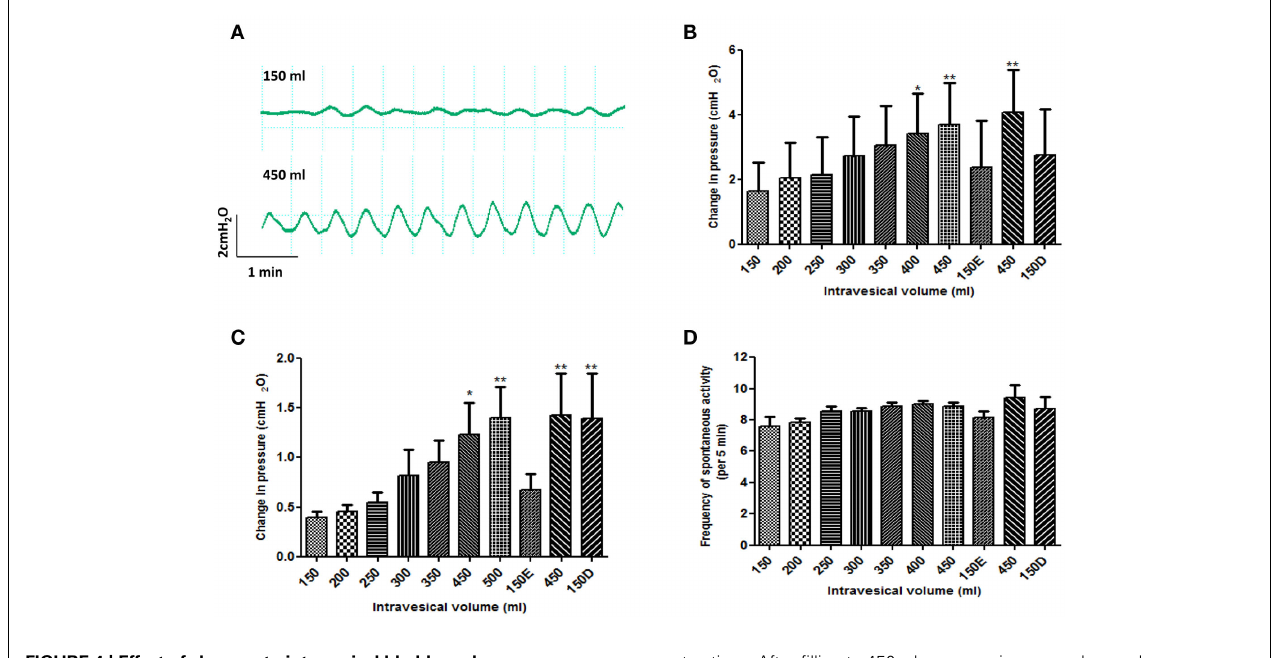
FIGURE 4 | Effect of changes to intravesical bladder volume on spontaneous contractions of isolated pig bladder. (A) spontaneous contractions generated at low (150ml) versus high (450ml) bladder volumes. (B) base-line intravesical pressure (C) amplitude of spontaneous contractions and (D) frequency of spontaneous